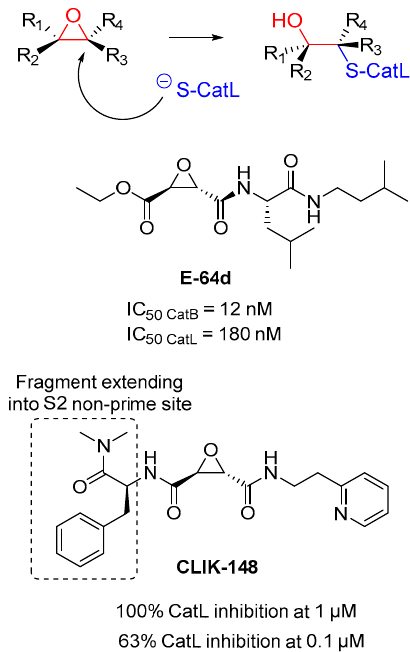
Figure 15. Structures and inhibitory activities of epoxysuccinates E-64d and CLIK-148 against human cathepins.